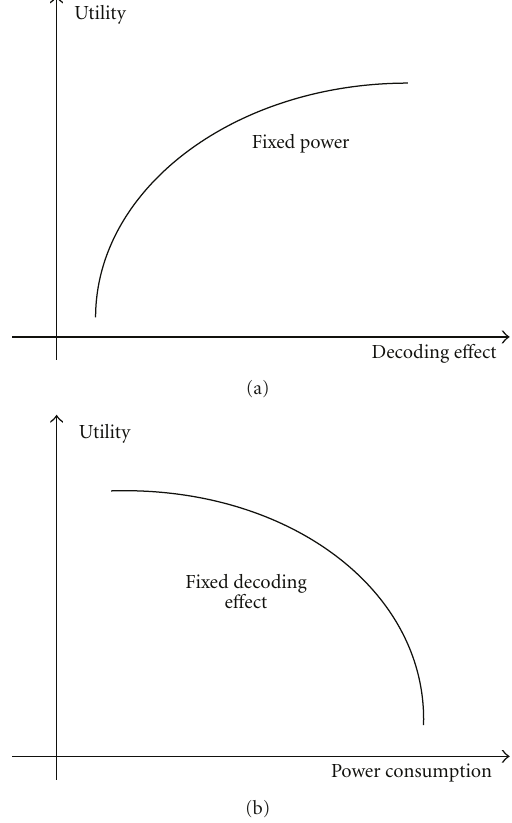
Figure 2: Utilities as a function of decoding e ff ect and power